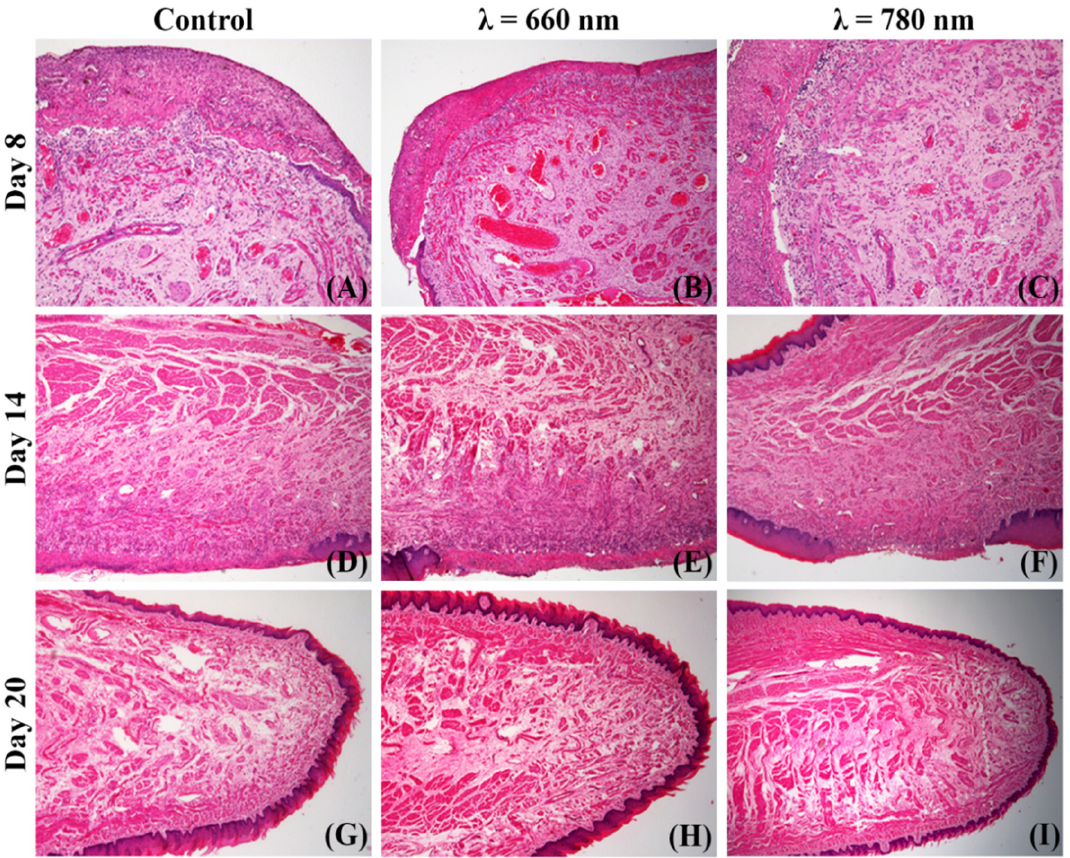
Figure 4. Representative histological fields showing the repair process of ionizing radiation-induced oral mucositis (control group, ( A , D , G )) treated with λ = 660 nm photobiomodulation (660 nm group, ( B , E , H )) or λ = 780 nm photobiomodulation (780 nm group, ( C , F , I )). The repair process was registered after 8 ( A – C ), 14 ( D – F ) and 20 days ( G – I ) of ionizing radiation (hematoxylin-eosin, × 20 or × 50 original magnification).